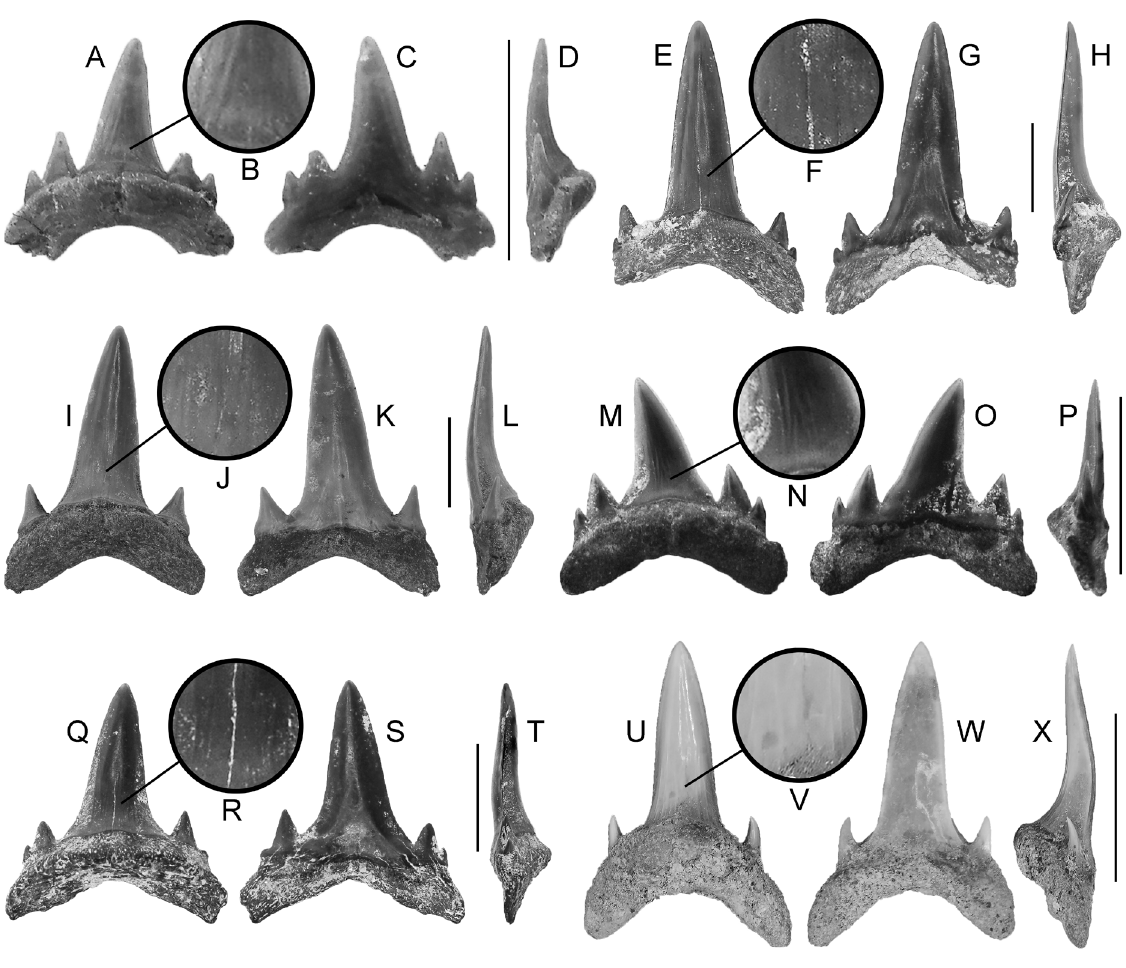
Fig. 12. Brachycarcharias atlasi (Arambourg, 1952), teeth. A – D . MSC 35762.1, lateral tooth,